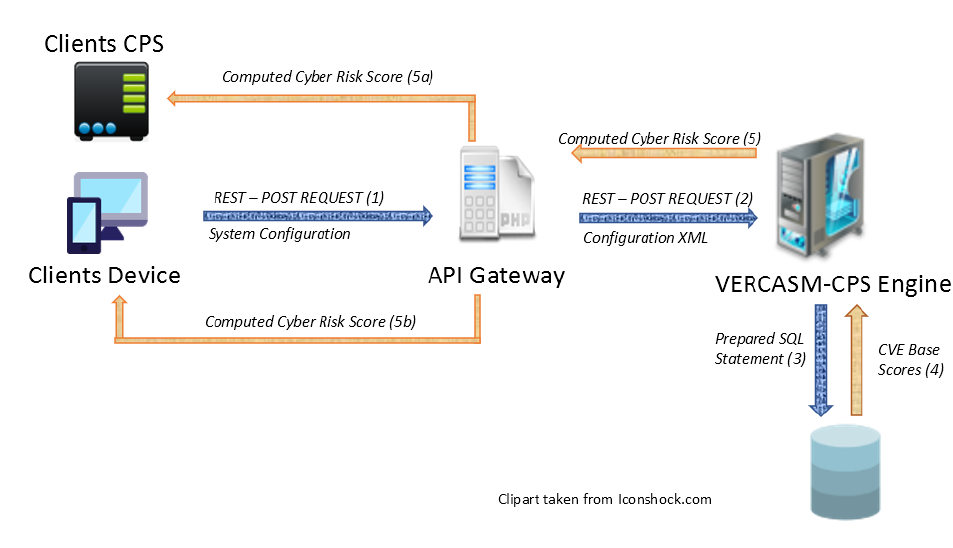
Figure 2. General Workflow of